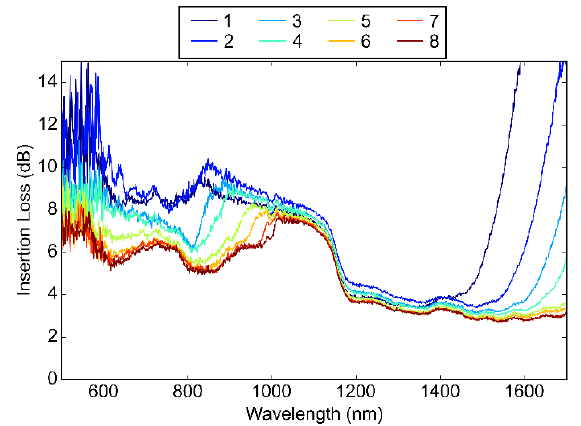
Fig. 2. Insertion loss of 2.4 cm long waveguides fabricated in Eagle 2000 at a depth of 50 + 0.5 × 𝑛 µm (where n is the waveguide number) after being etched to the surface in HF 10%.